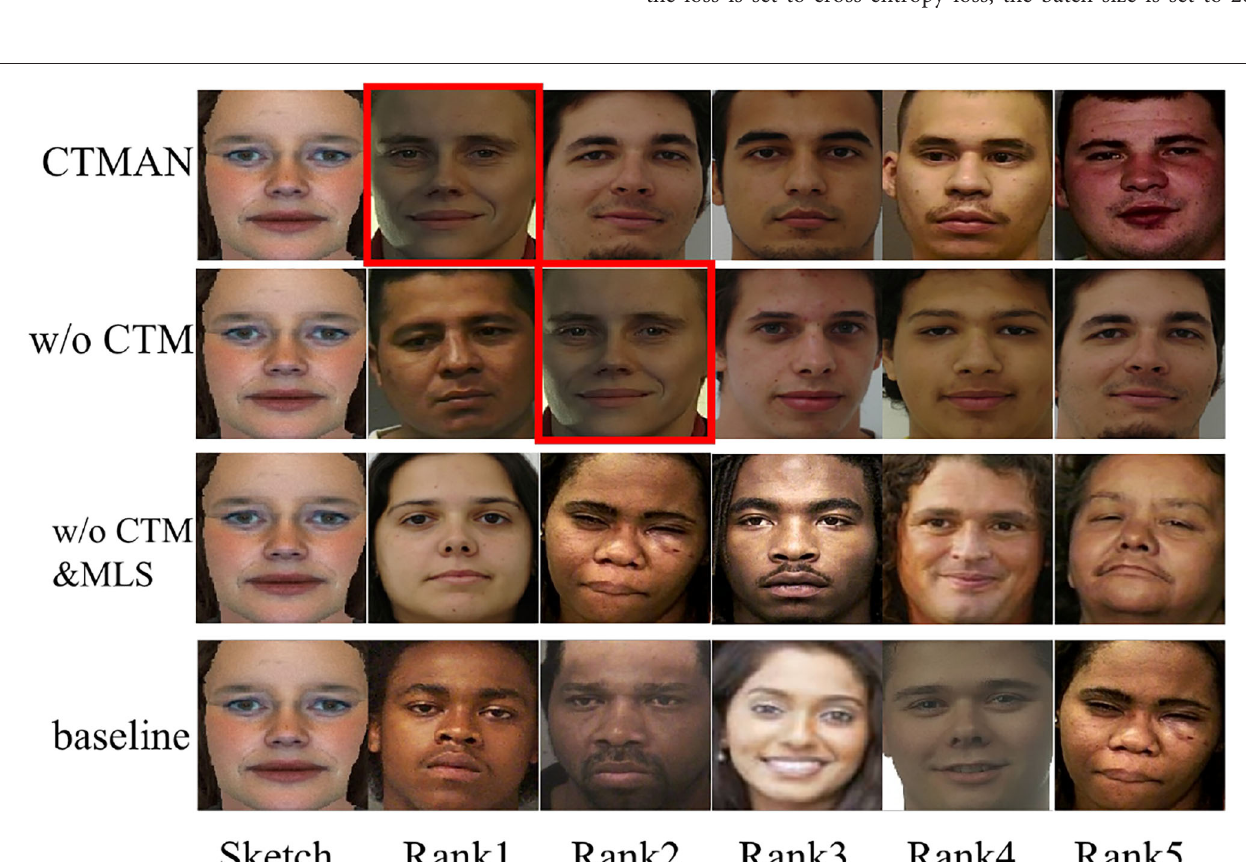
FIGURE 5 | The top five matching photos of CTMAN, w/o CTM, w/o CTM&MLS, and baseline on the S1 setup, images in red box are the groundtruth.